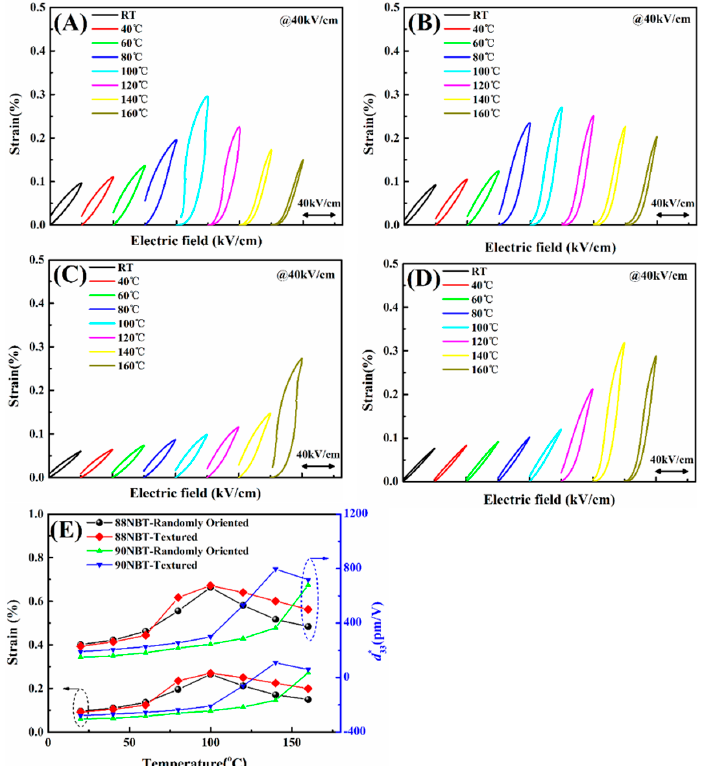
Figure 6. Temperature-dependent of unipolar strain curves of ( A ) 88NBT randomly oriented ceramic, ( B ) 88NBT textured ceramic, ( C ) 90NBT randomly oriented ceramic, and ( D ) 90NBT textured ceramic; ( E ) Strain and d 33 * as a function of temperature for 88NBT and 90NBT ceramics at 40 kV/cm.